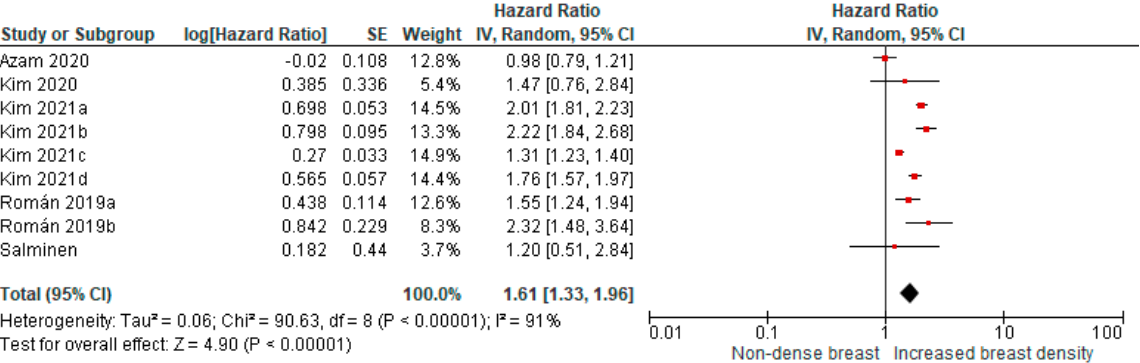
Figure 2. Pooled analysis for breast cancer risk in relation to increased breast density over time (cohort studies). Kim 2021a: